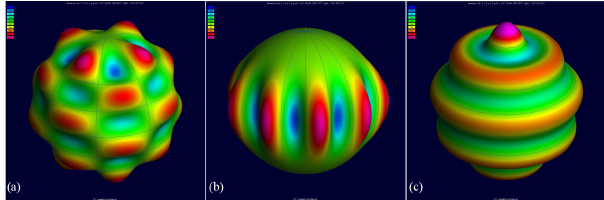
Figure 4. 3-D visualization of spherical harmonics as a tutorial. The images show one specific surface spherical harmonic of degree l and order m such as (a) tesseral ( l = 9, m = 4), (b) sectorial ( l = 9, m = 9), and (c) zonal ( l = 9, m = 0) spherical